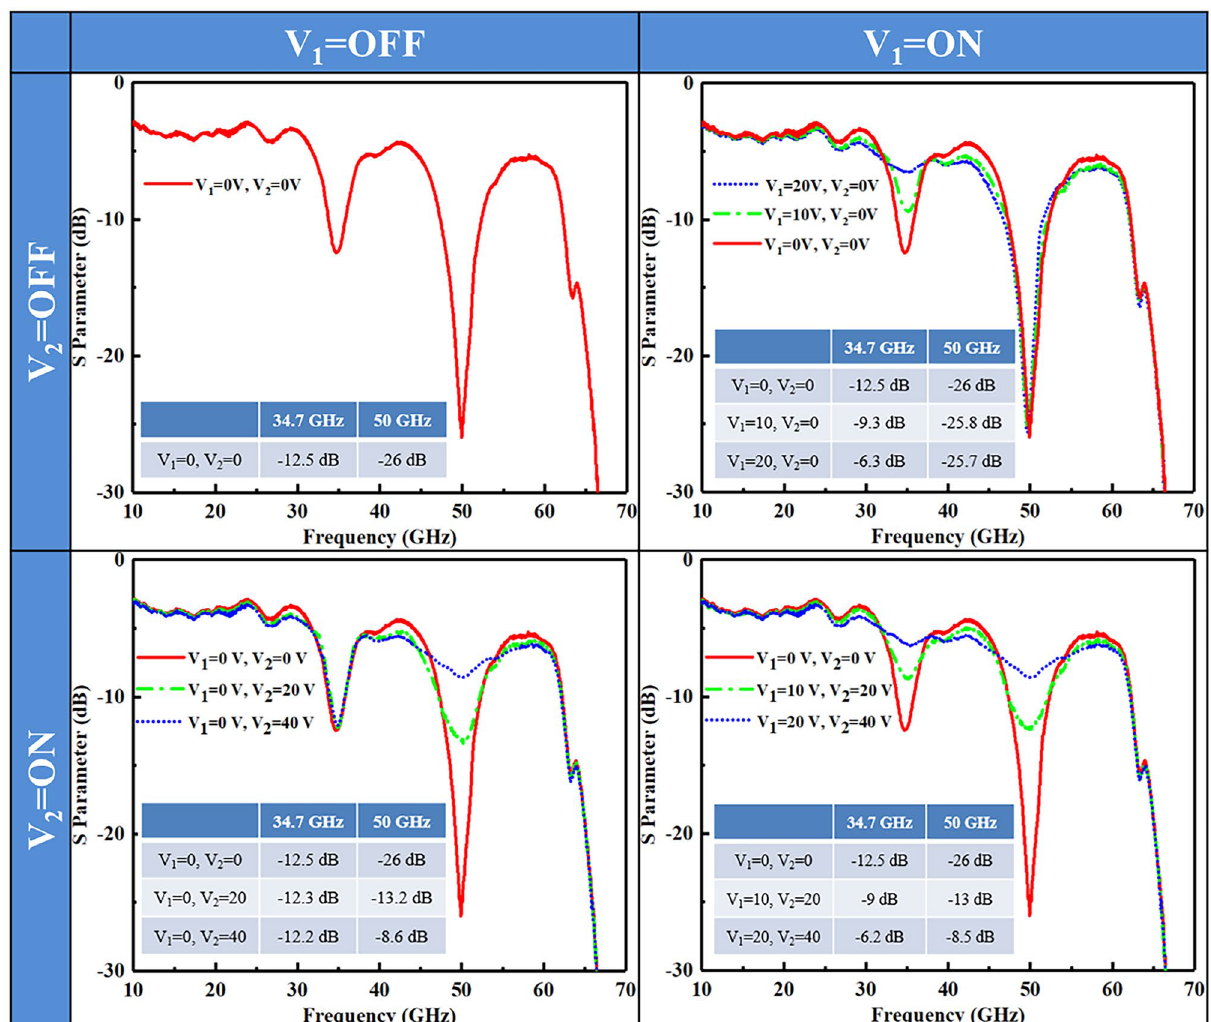
Figure 5. Dual-frequency multi-bit AM of spoof SPPs with individual bias. The inset shows the transmission values under various bias at 34.7 and 50